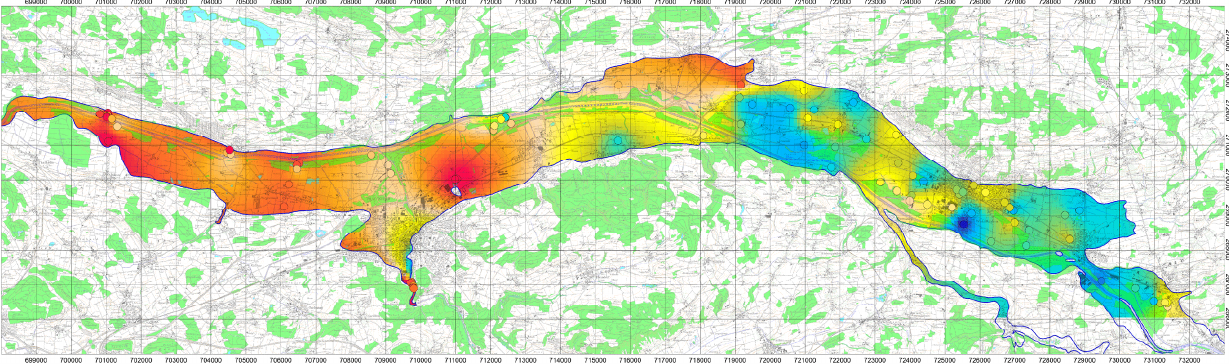
Fig. 3. Plan view representation of oxygen concentrations in the groundwater of River Thur valley, using CHEMMAP. Yellow, orange, and red hues, low concentrations ( < 5mgL − 1 ), light and dark blue hues, high concentrations ( > 5mgL − 1 ). Colored domain: alluvial groundwater, thickness > 2m. North is up; General groundwater flow direction from East to